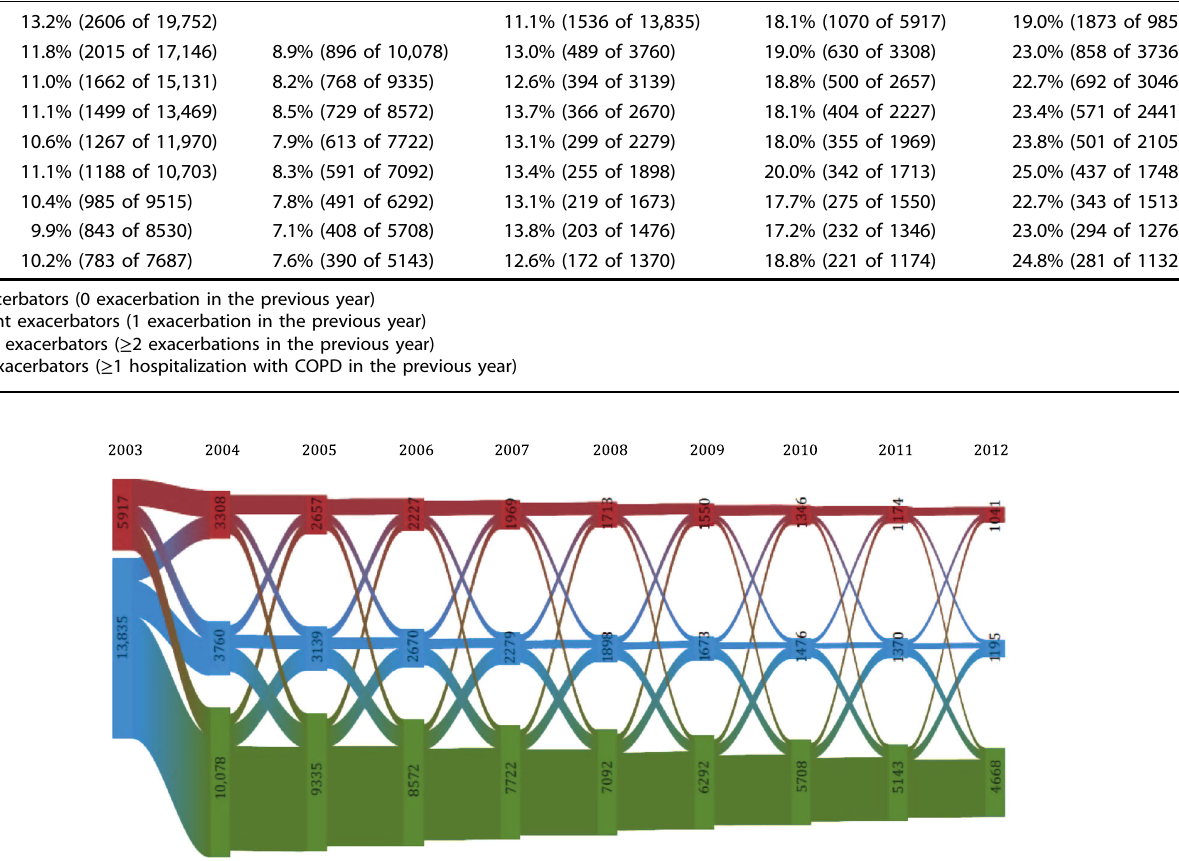
Table 2. One-year mortality according to exacerbation rate in the previous year All